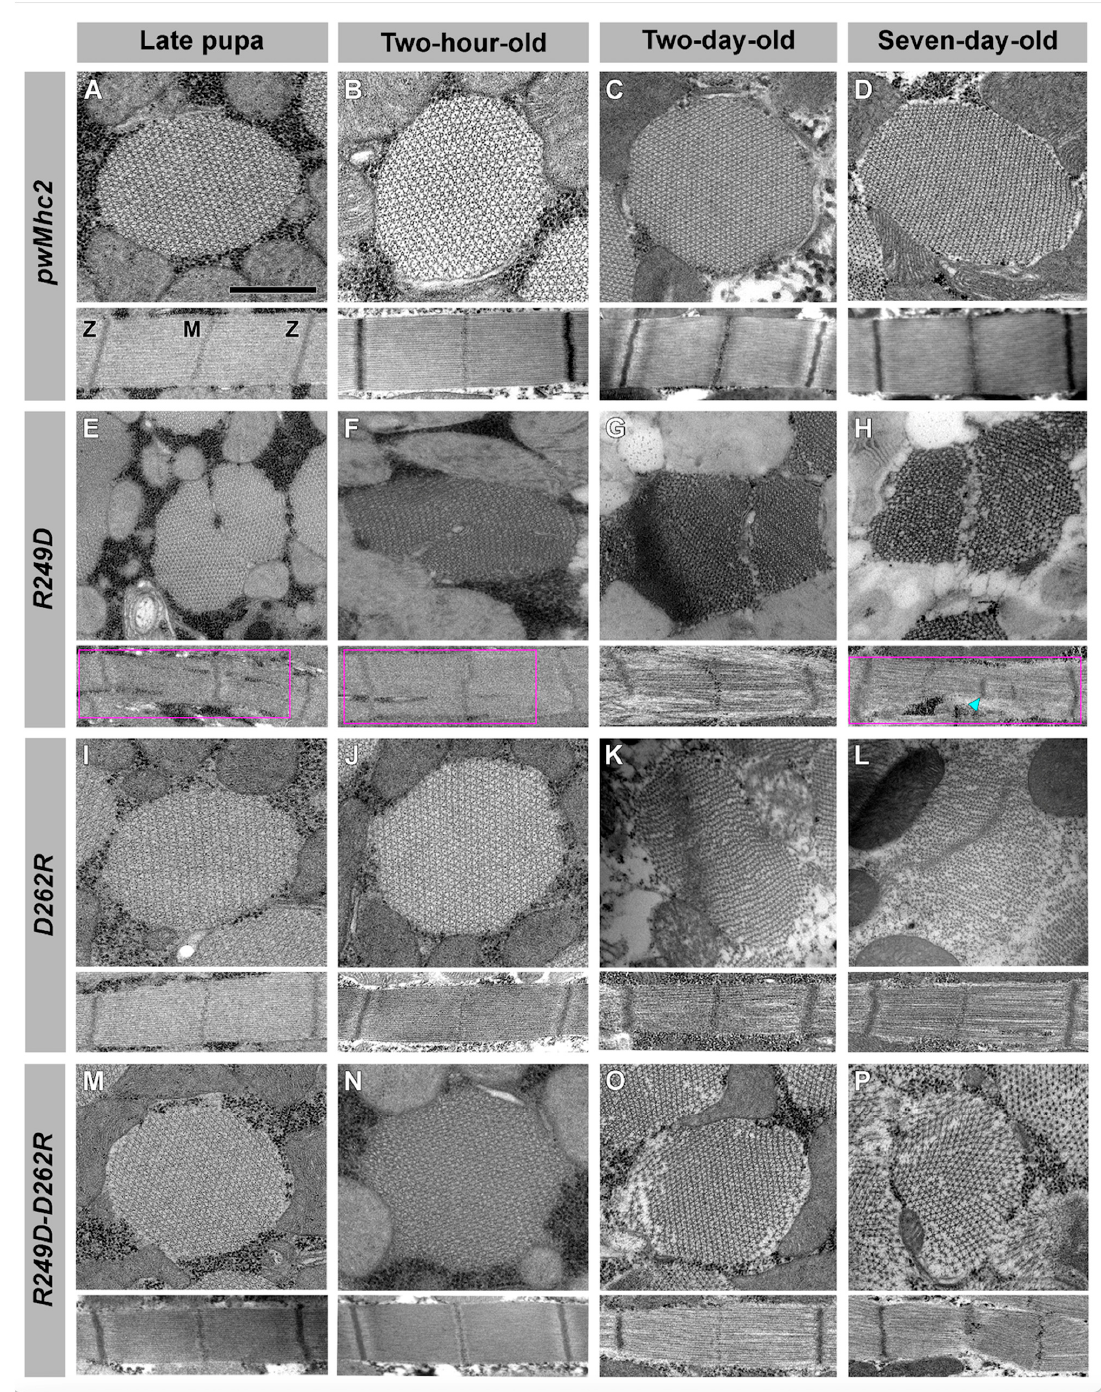
Figure 4. Transmission electron microscopy of R249D , D262R and R249D-D262R myofibrils shows severe defects in R249D that are largely rescued in the double mutant. Transverse and longitudinal sections from ( A ) pwMhc2 late-stage pupae, ( B ) pwMhc2 two-hour-old adults, ( C ) pwMhc2 two-day-old adults, ( D ) pwMhc2 seven-day-old adults. Transverse sections display thick and thin filaments in a normal double-hexagonal pattern throughout development and aging. Longitudinal sections show regularly spaced Z- and M-lines. ( E ) Transverse and longitudinal sections from pwMhcR249D